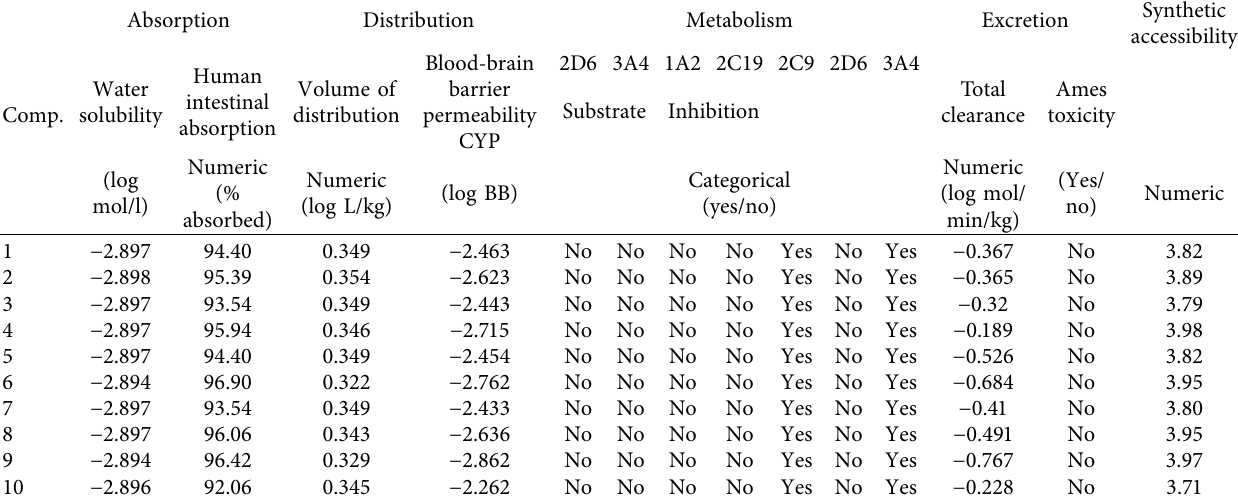
Table 9: In silico ADMET prediction and synthetic accessibility values of newly designed compounds.